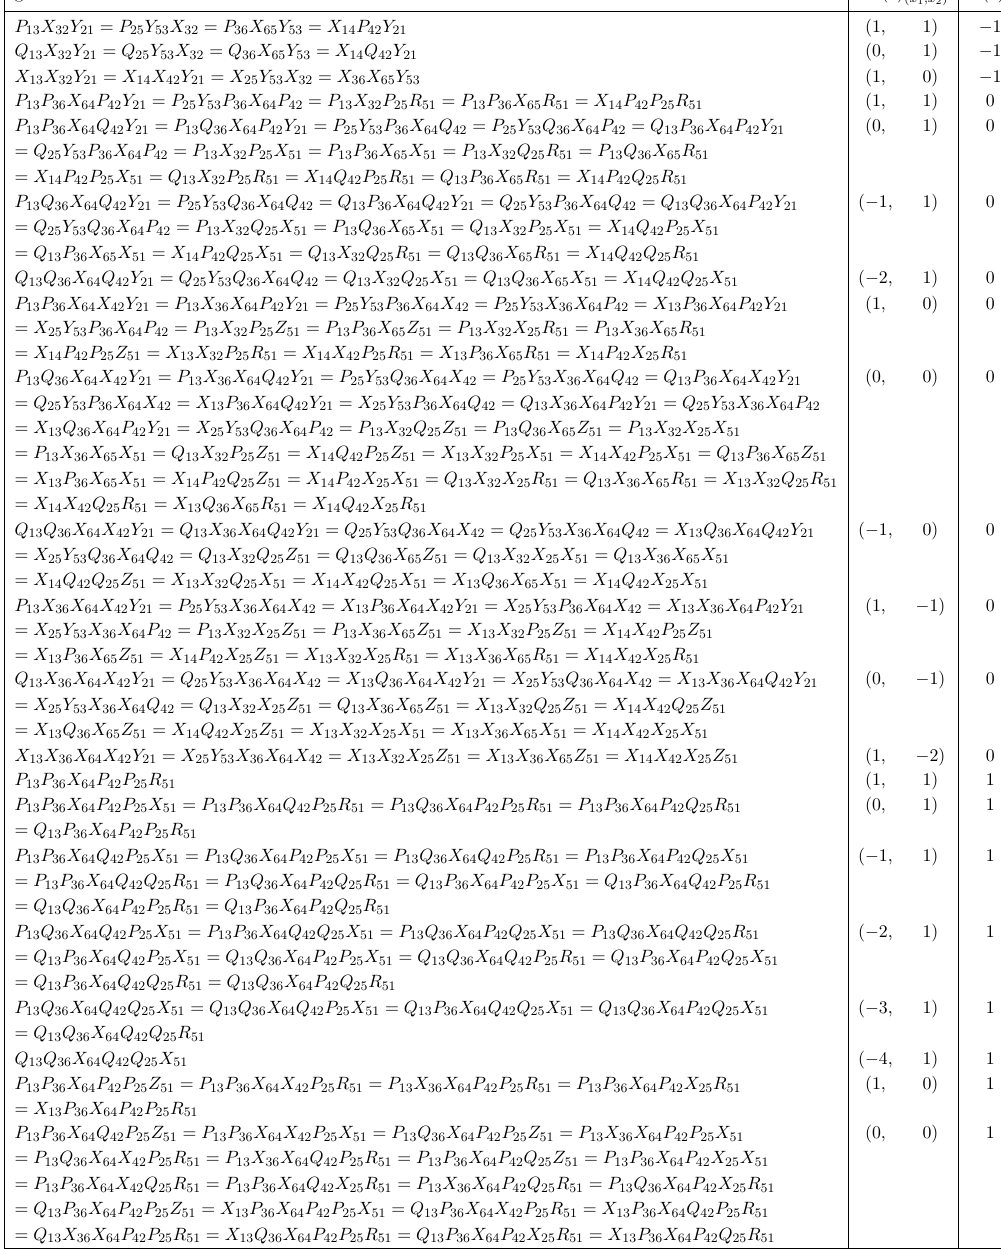
Table 21 . The generators in terms of bifundamental chiral fields for Model 5 (Part 1)